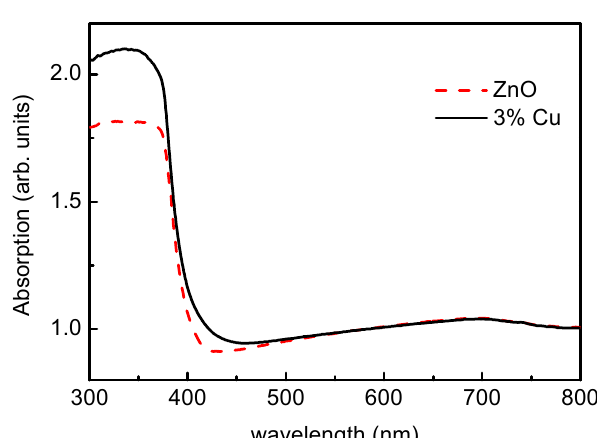
Figure 9. Absorption of Cu x Zn 1-x O.